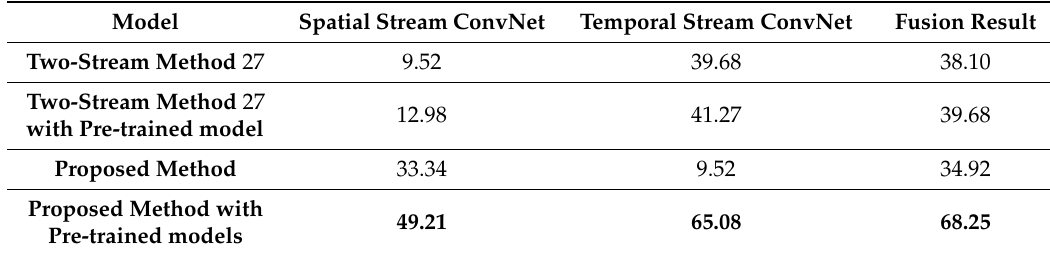
Table 2. Accuracy rate in the self-compiled dataset.